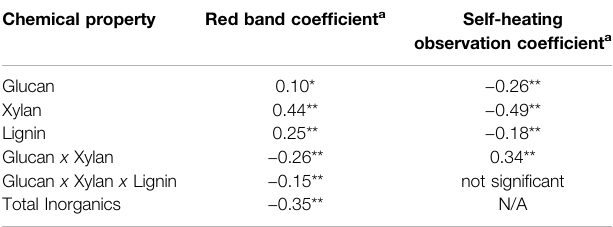
TABLE 1 | Chemical properties are used to form linear regressions for explaining the red-band and biological degradation/self-heating observation variability. Chemical